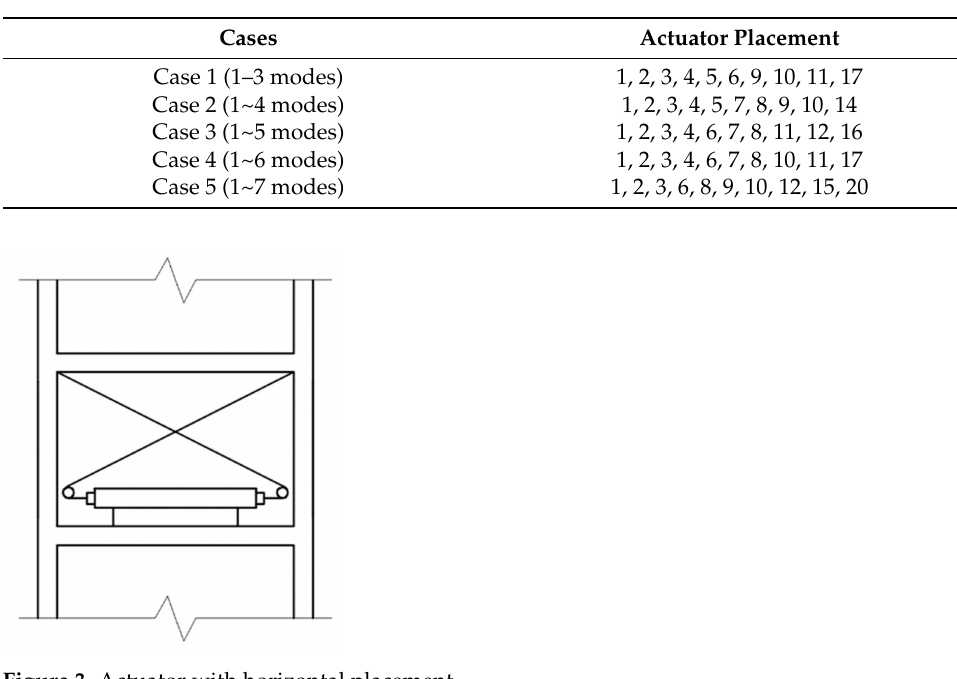
Table 3. Actuator placement in different MDM selections.